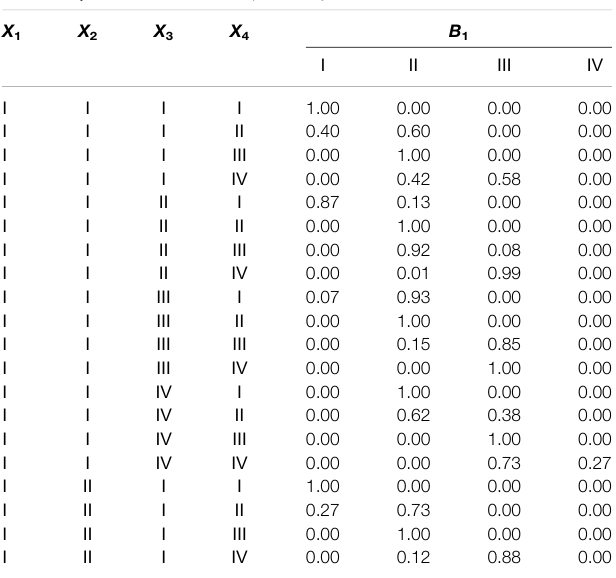
TABLE 4 | Multistate conditional probability table.